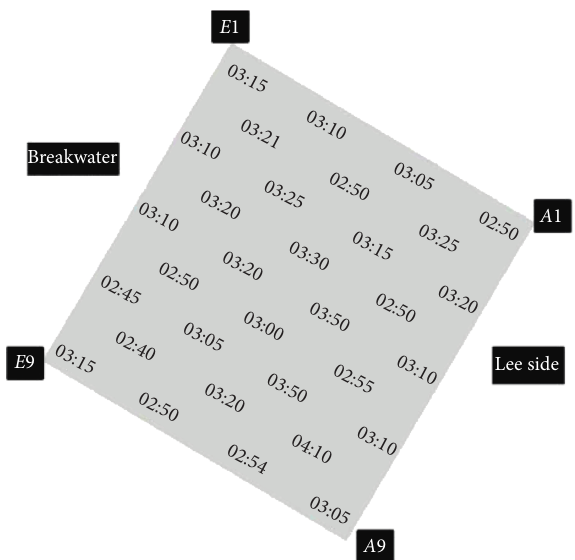
Figure 27: The sinking time of the second-stage piling in the range of caisson R5-8 in minutes.